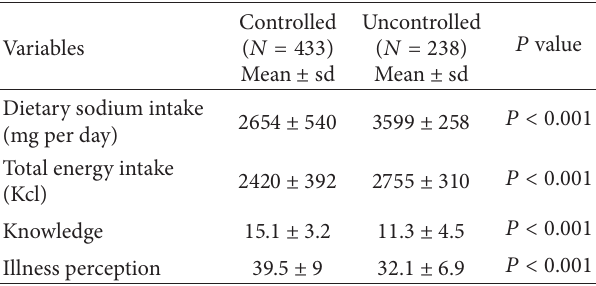
Table 2: Sodium intake among controlled 1 and uncontrolled 2 hypertensive patients.